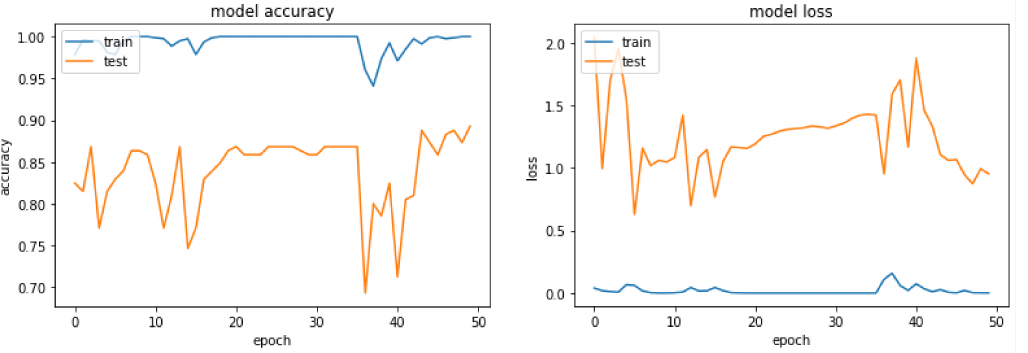
Figure 21. Model accuracy and model loss plots of the DenseNet121 model for image sentiment prediction.